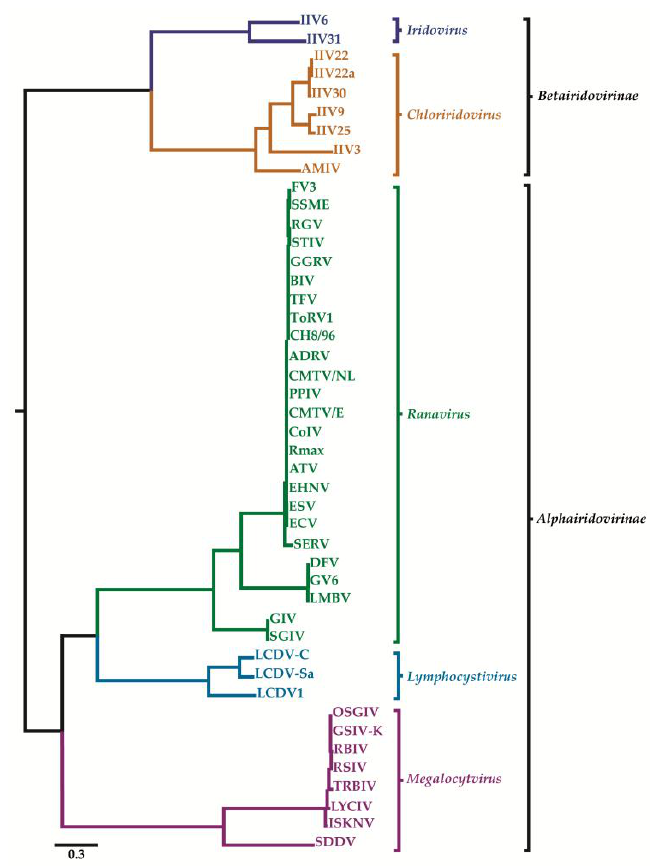
Figure 2. ML analysis based on 26 core genes conserved among all members of the family Iridoviridae (iridovirids). The phylogram shows a clear division of genera within the Alphairidovirinae ( Ranavirus , green; Lymphocystivirus , cyan; Megalocytivirus , purple) and Betairidovirinae ( Iridovirus , blue; Chloriridovirus , brown) subfamilies. Virus species and isolates are indicated by abbreviations, listed in Table 2. Members